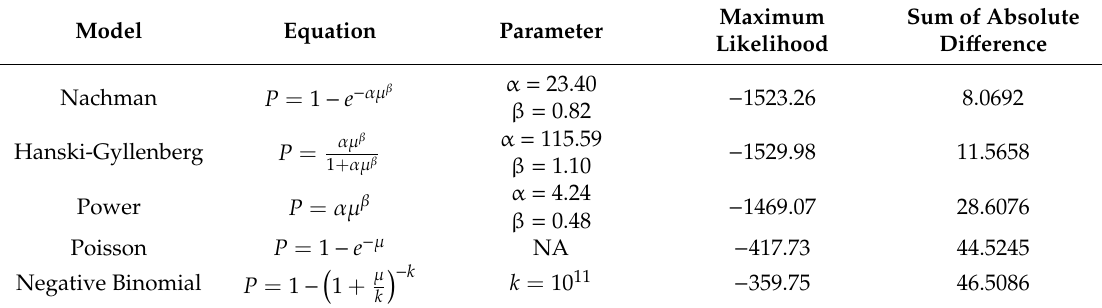
Table 1. Modelling parameters for the occupancy-abundance